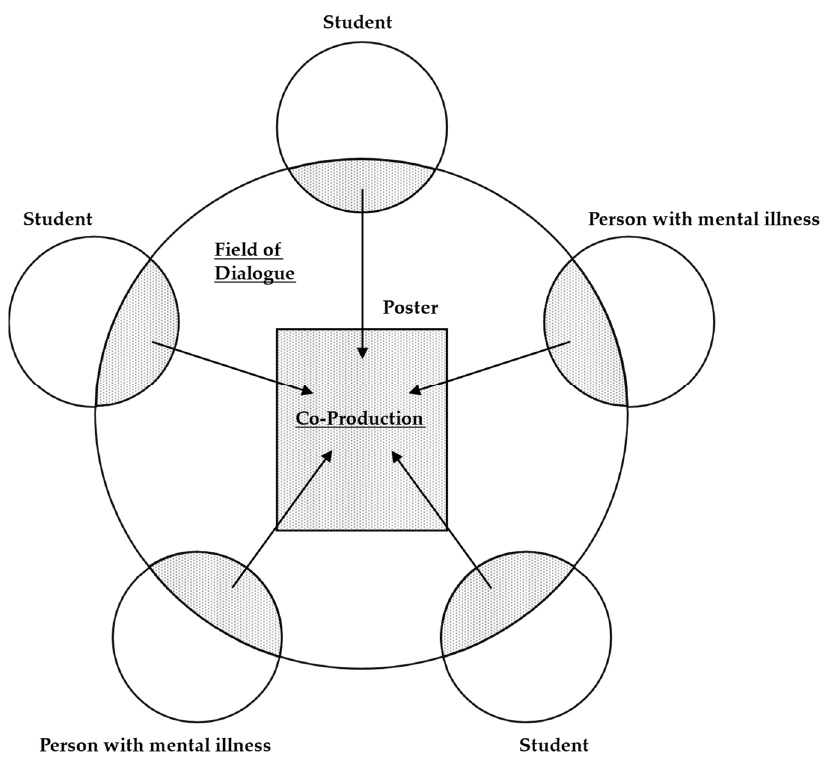
Figure 1. Co-Production with Dialogue Program for Reducing